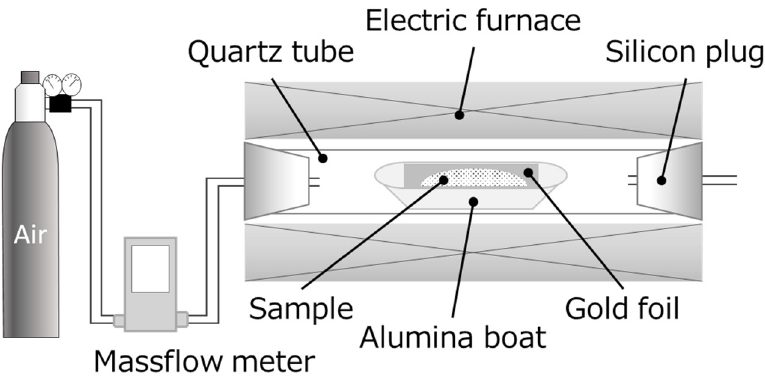
Figure 2. Schematic of the calcination apparatus.